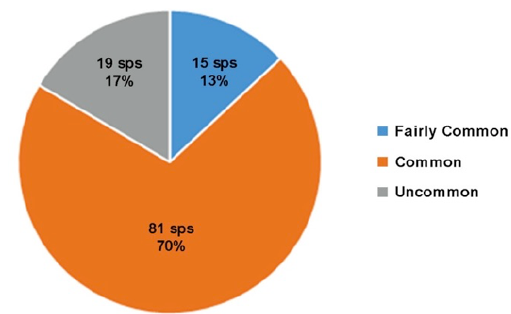
Figure 1. Abundance of the bird species in scrubland of Sri Lankamalleswara Wildlife Sanctuary, Andhra Pradesh,